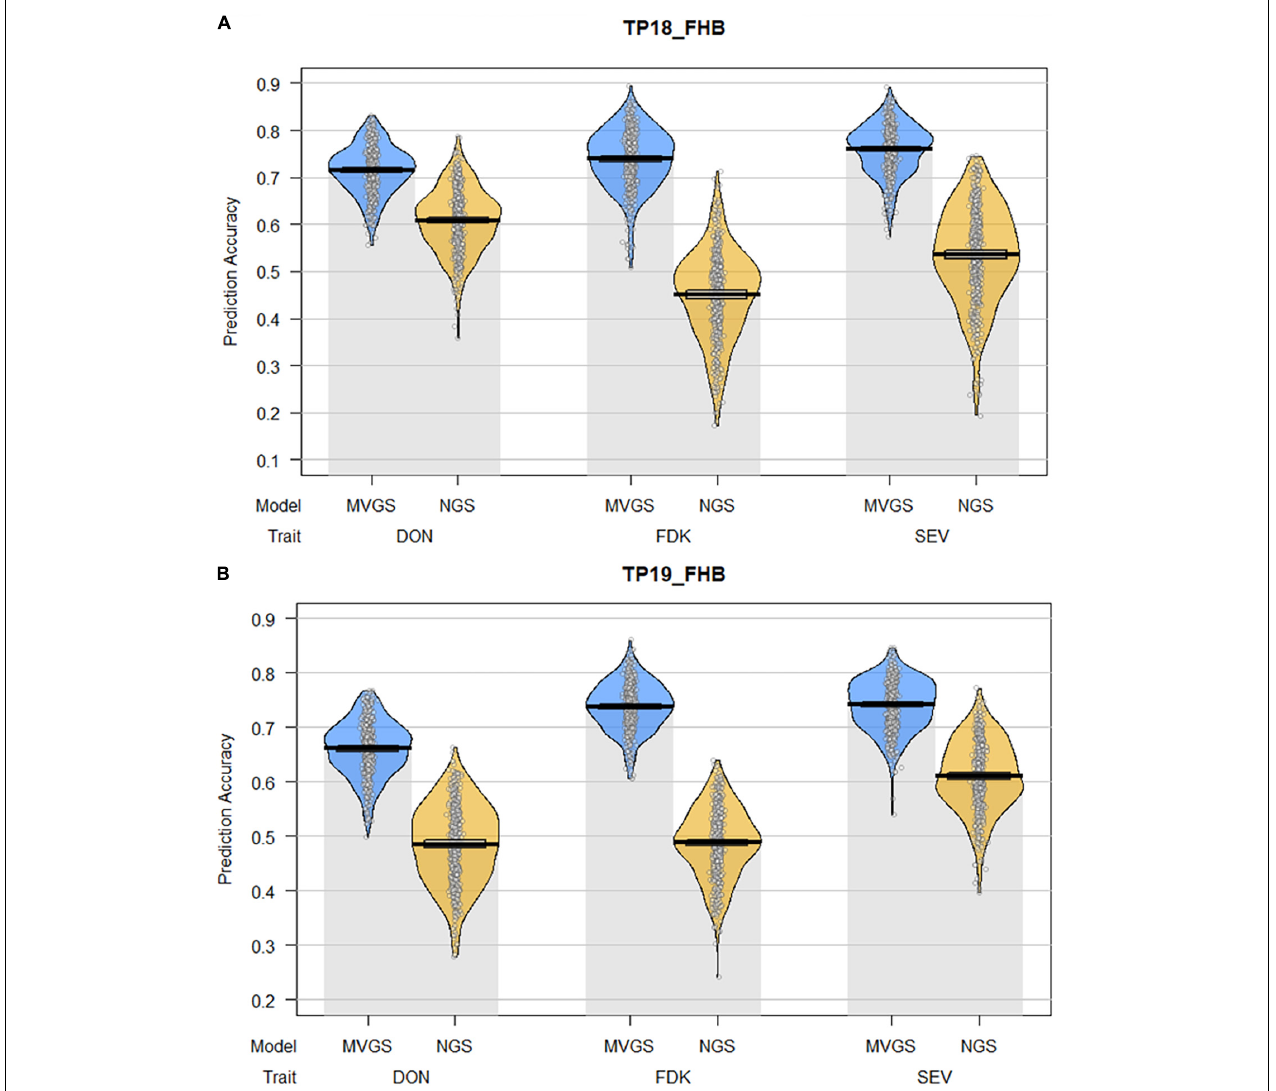
FIGURE 2 | Pirate plots comparing the mean prediction accuracies between multi-trait genomic selection (MTGS) models with naïve genomic selection (NGS) models for three Fusarium head blight resistance traits (FHB), deoxynivalenol (DON) concentration, Fusarium damaged kernels (FDK), and severity (SEV) in soft red winter wheat across two training populations (TPs): (A) TP18_FHB, TP used to predict three FHB resistance traits for the 2018 advanced F 4 : 7 generation (ADV18); (B) TP19_FHB, TP used to predict three FHB resistance traits for the 2019 advanced F 4 : 7 generation (ADV19), consisting of all genotypes from TP18_FHB and ADV18. The x- axis represents the combination of FHB resistance traits and GS model used to predict each trait. The y- axis represents the mean prediction accuracy across 100 iterations of fivefold cross-validation in the form of a Pearson correlation coefficient ( r ) between the predicted genome-estimated breeding value (GEBV) and the actual phenotypic value for the validation populations. Individual points represent the Pearson correlation from each fold of each iteration of cross-validation for a total of 500 data points. The lines within each plot represent the mean and 95% confidence intervals for prediction accuracy. The curves represent the smoothed densities of the